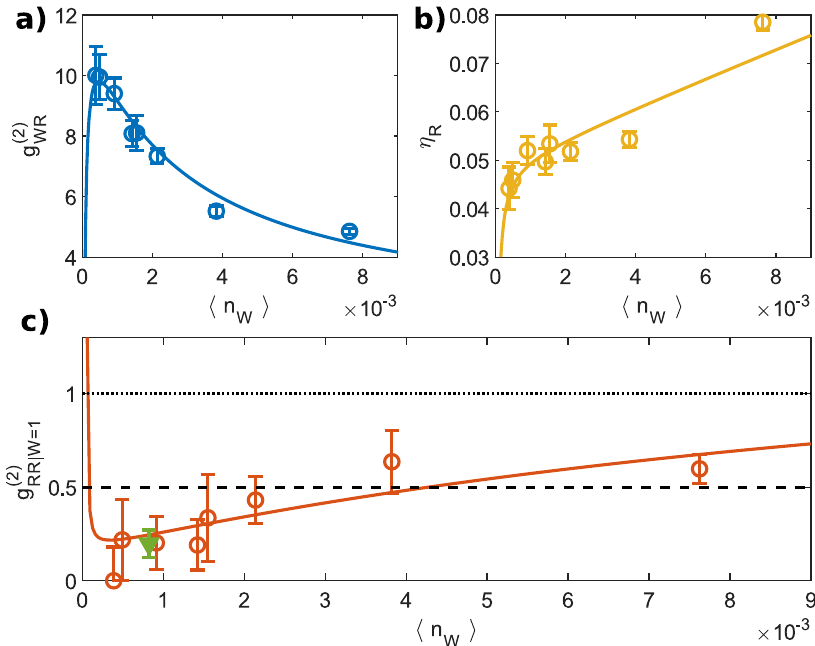
, b retrieval ef fi ciency η R and c 2nd-order conditional auto- Fig. 3 Photon correlations and retrieval ef fi ciency. a 2nd-order cross-correlation function g ð 2 Þ WR = 1 (dotted line) is the classical limit and g ð 2 Þ = 0.5 (dashed line) is the two-photon Fock correlation function g ð 2 Þ of the retrieved light fi eld. g ð 2 Þ (cid:7) (cid:3) RR j W ¼ 1 RR j W ¼ 1 RR j W ¼ 1 state auto-correlation value. All functions are plotted against the mean number of detected write counts n . Shown are measured data (circles) and the (cid:7) (cid:3) W model (full lines). To improve the experimental uncertainty on g ð 2 Þ we combine points for n W < 2 ´ 10 (cid:3) 3 (green triangle). Error bars represent one RR j W ¼ 1 standard deviation. Source data are provided as a Source Data fi